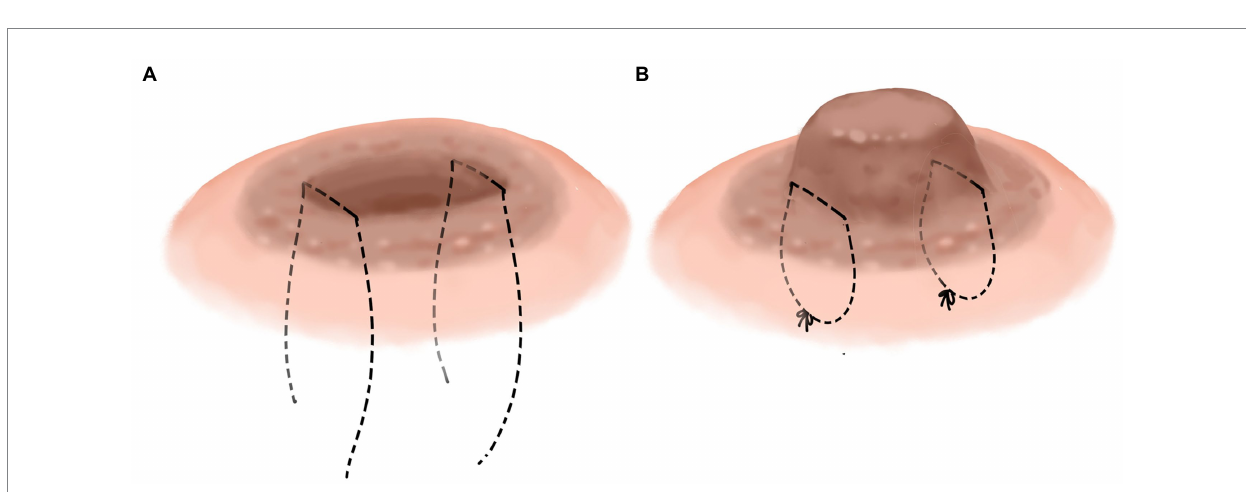
FIGURE 3 Nipple depression with perfect development. Sew “-” on both sides of the nipple root, respectively, (A) then turn the nipple out and tighten the knotted suture, respectively, (B)